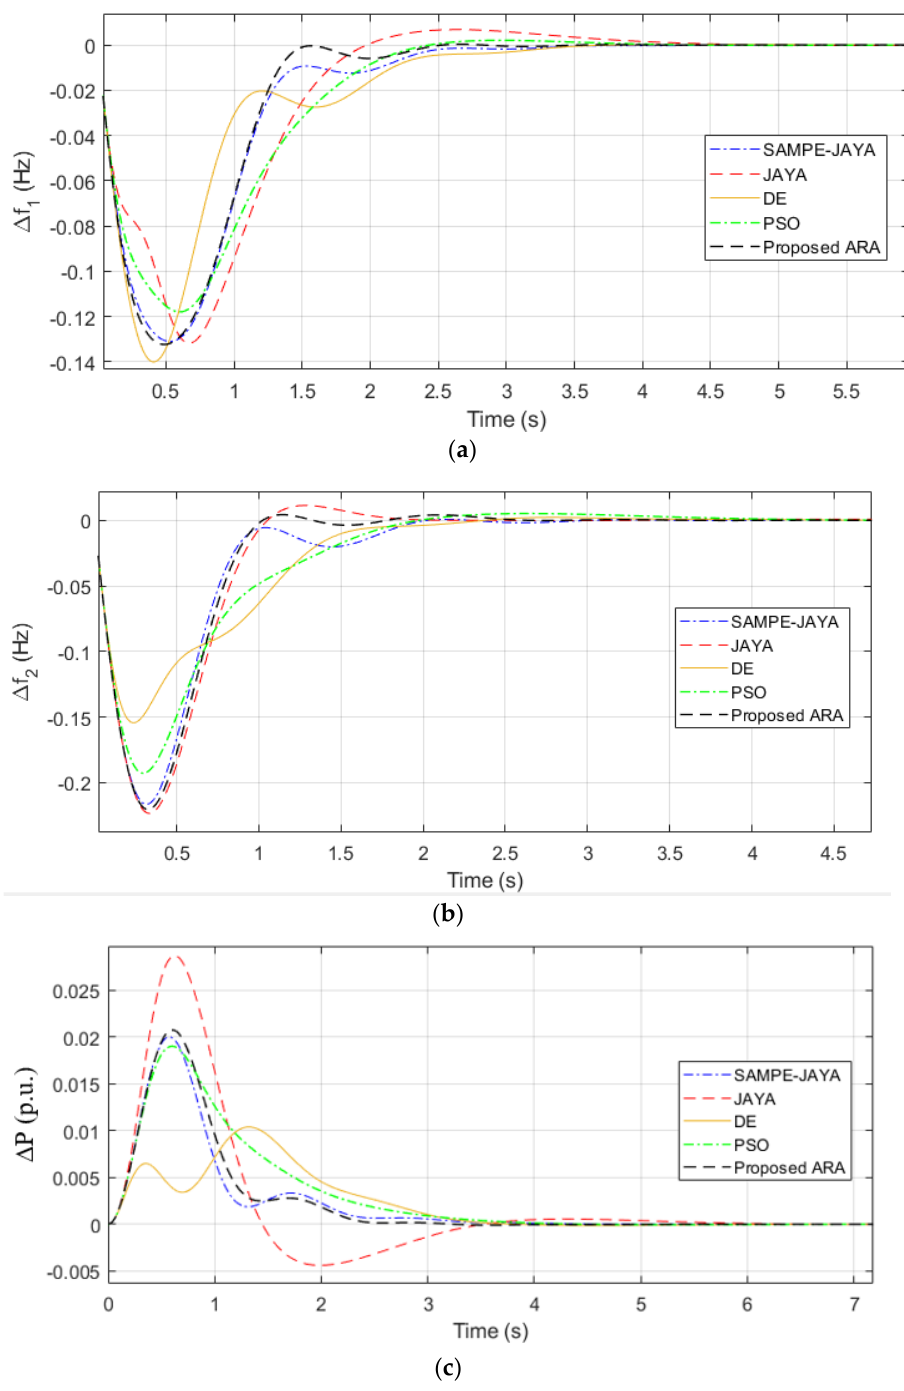
Figure 8. Dynamic responses for SAMPE-JAYA, JAYA, DE, PSO and the proposed ARA under case study 3. ( a ) Change in frequency in area 1. ( b ) Change in frequency in area 2. ( c ) Tie-line power deviation. Table 5. Settling times (s) under Case Study 3.